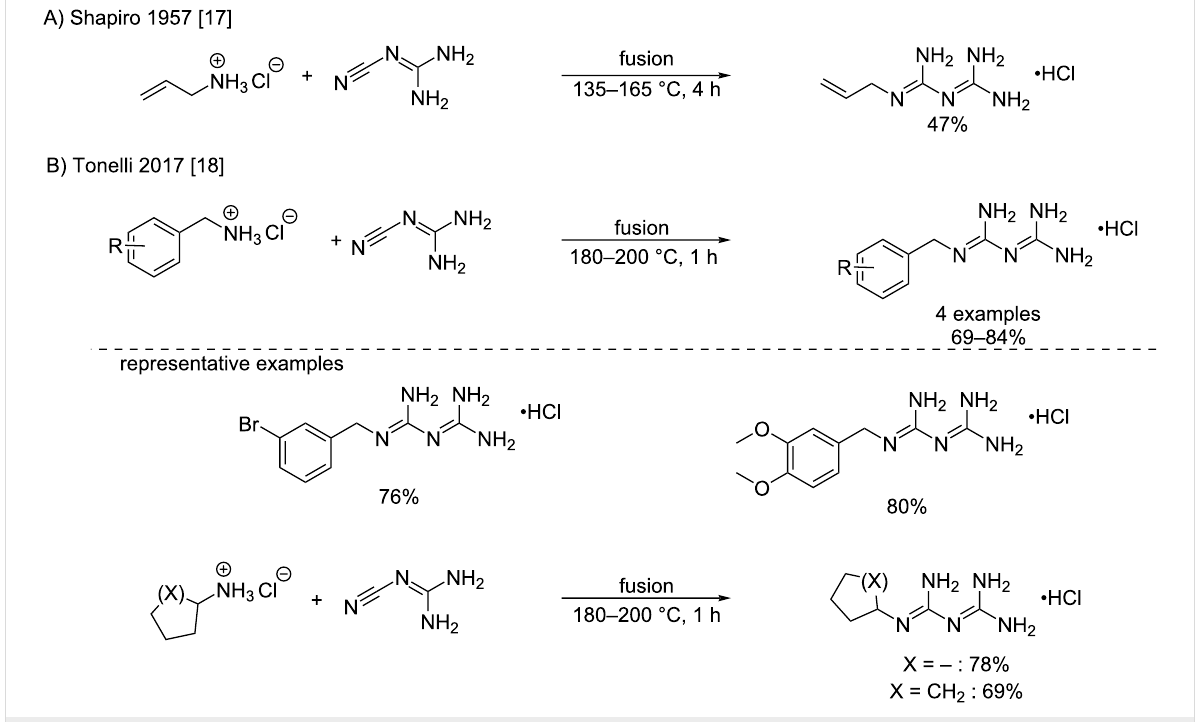
Scheme 3: Synthesis of biguanides by the direct fusion of cyanoguanidine and amine hydrochlorides [17,18].